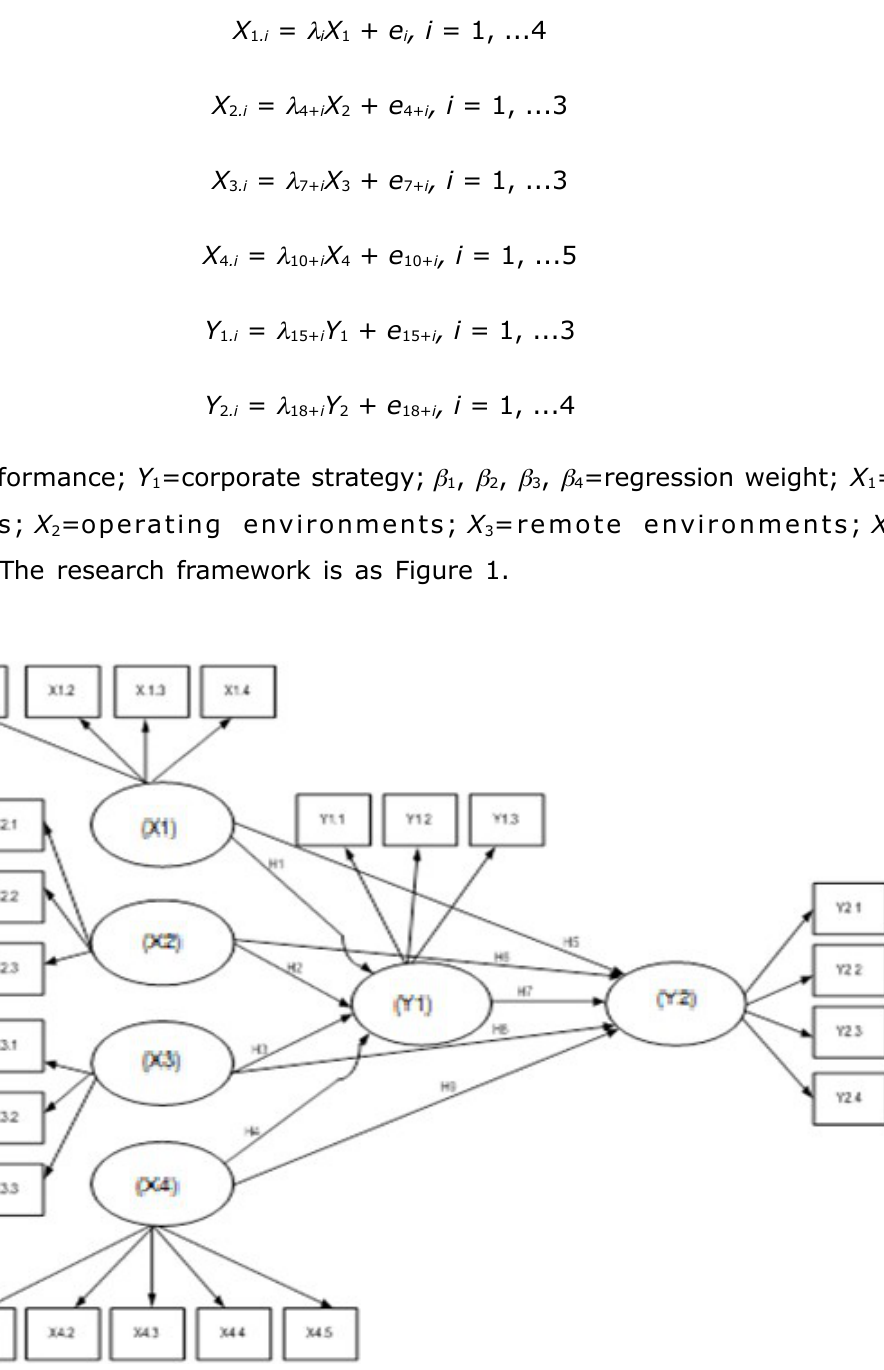
Figure 1. The research